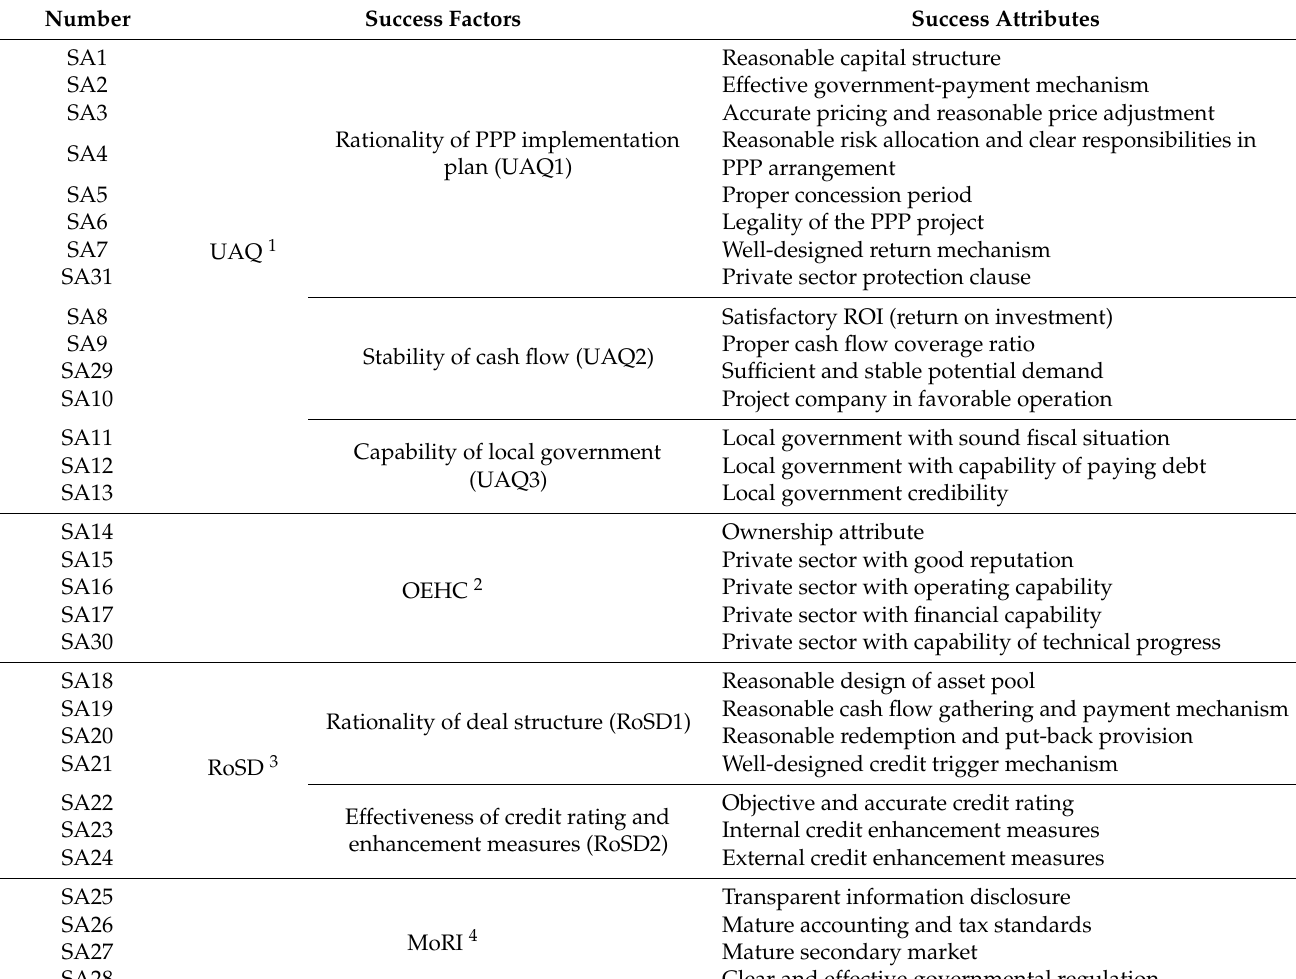
Table 2. Success factors and attributes (Source: Experts’